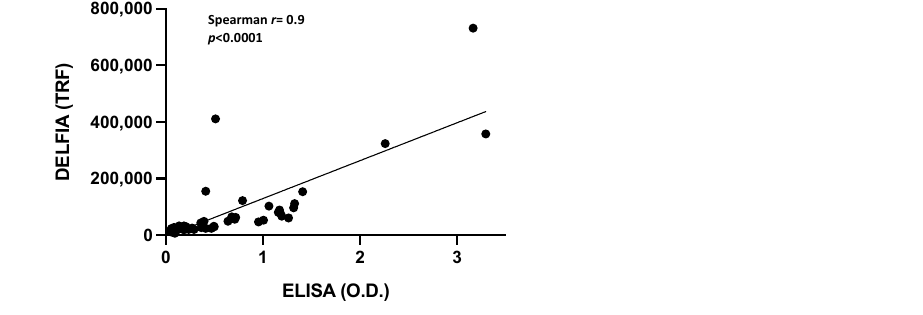
Figure 2. Correlation between DBS-DELFIA and plasma ELISA for SARS-CoV-2 nucleocapsid IgG antibody detection.